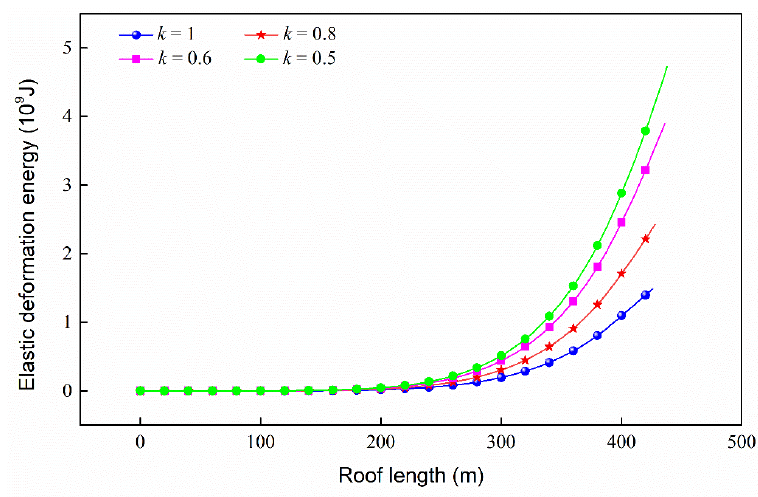
Figure 9. Variation law of the EDE of a roof with different supporting force coefficients.